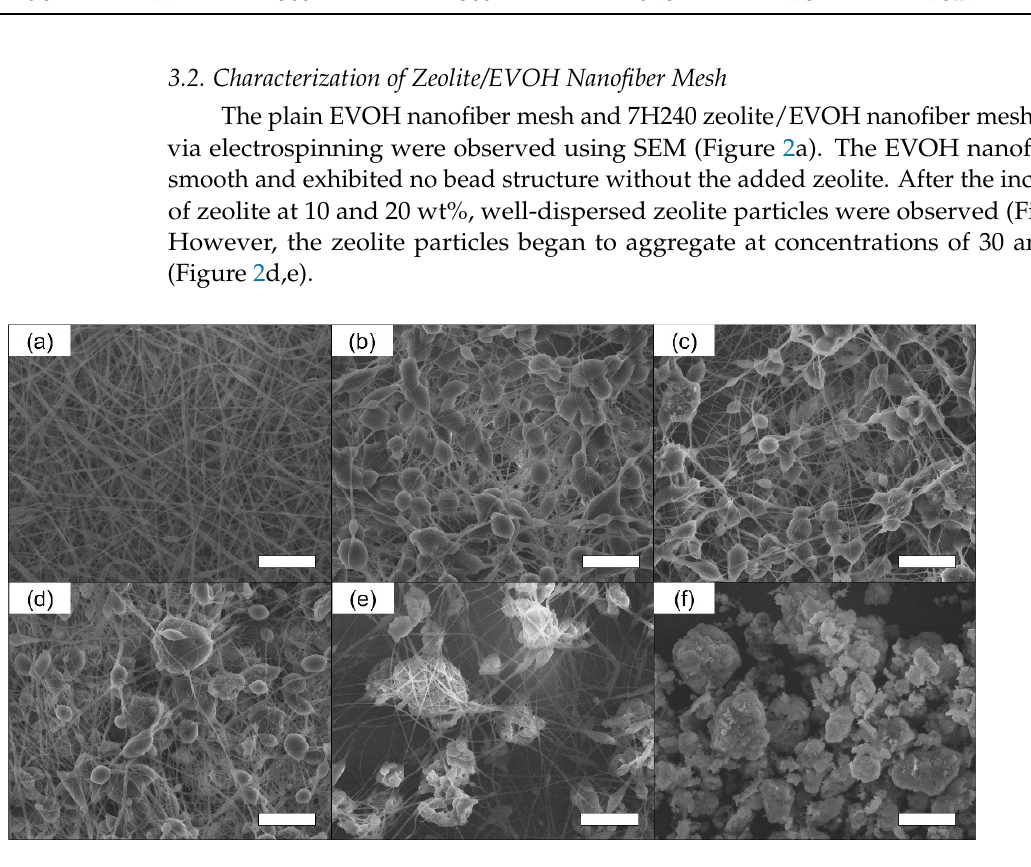
Figure 2. ( a–e ) SEM images of the 7H240 zeolite/EVOH nanofiber mesh at zeolite concentrations of ( a ) 0, ( b ) 10, ( c ) 20, ( d ) 30, and ( e ) 40 wt%. ( f ) SEM image of zeolite 7H240 powder. Scale bar: 20 μ m.